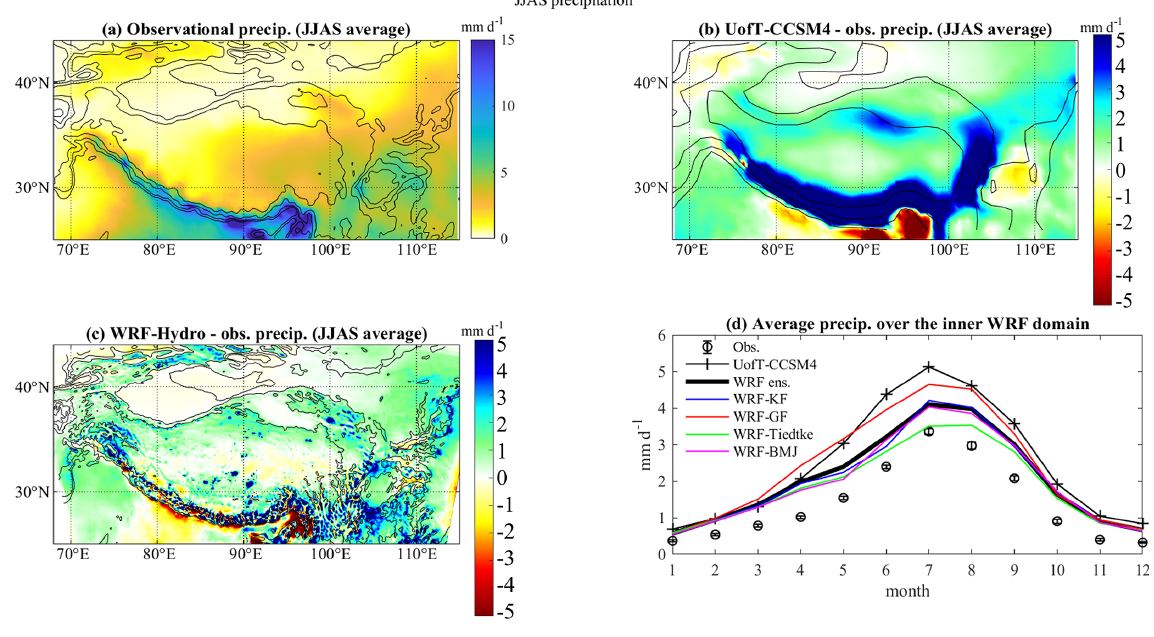
Figure 3. JJAS precipitation bias with respect to (a) the APHRODITE observational dataset for (b) UofT-CCSM4 and (c) the WRF ensemble. (c) Monthly precipitation over the inner WRF domain in the observation, UofT-CCSM4, WRF ensemble average and four individual physics ensemble members. The topography contours of 500, 1000, 2000, and 4000m are also shown in black in (a) – (c)